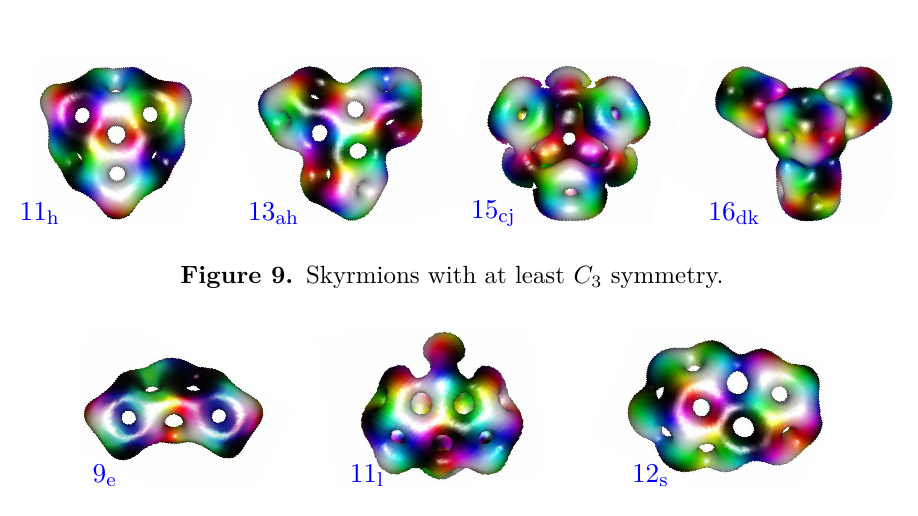
Figure 10. Solutions whose constituent clusters aren’t solutions